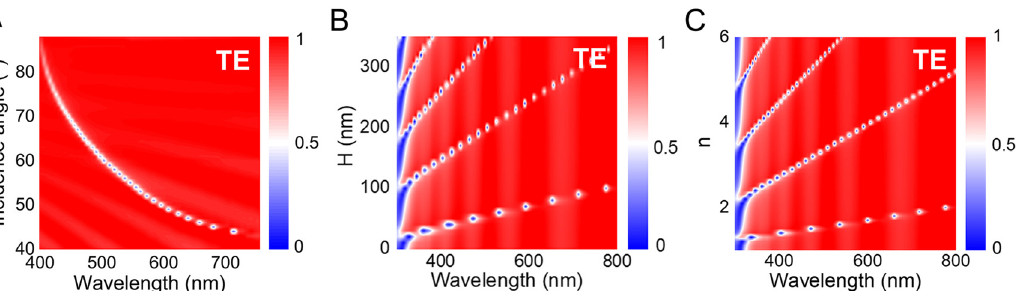
Figure 3: (A) Dependence of the resonant wavelength of the lowest-order TE wave on the incidence angle of the excitation s -polarized light calculated for a Si 3 N 4 /Ag heterostructure with h = 90 nm. (B) Thickness dispersion relations calculated for TE waves of different orders supported by Si 3 N 4 /Ag heterostructures with Si 3 N 4 layers of different thicknesses. (C) Refractive index dispersion relations calculated for TE waves of differentorderssupportedby dielectric-metal heterostructureswith dielectriclayers of differentrefractive indices.In (B)and (C), the angle of the incident wave was fi xed at 45 °